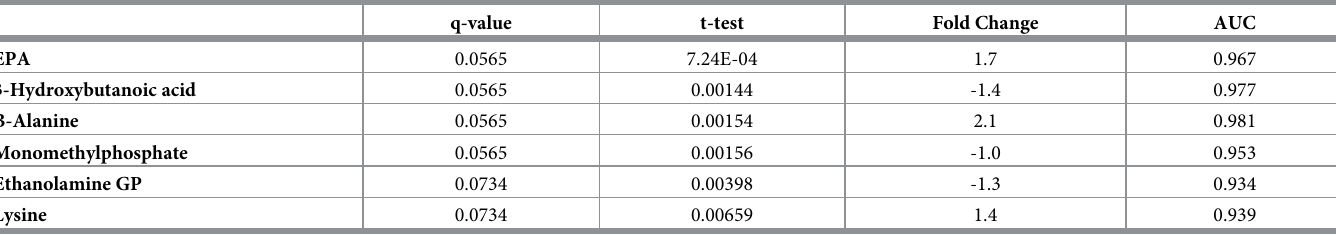
Table 5. Liver metabolites that differed in silver carp ( Hypophthalmichthys molitrix) sampled from leading edge vs. downstream locations within the Illinois